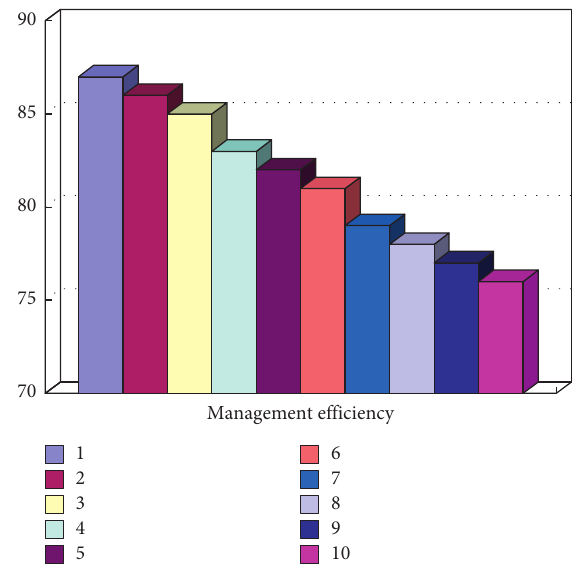
Figure 7: Experimental data table of multipoint mapping